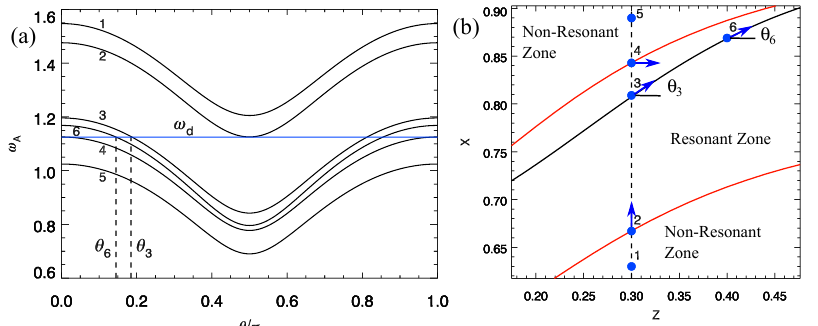
Figure 5. ( a ) The variation of natural Alfvén frequency, ω A , with polarisation angle, θ , for six different field lines, labelled 1–6. The horizontal blue line denotes the driving frequency, ω d . ( b ) The intersections of these field lines with the vertical ( x , z ) plane that runs the length of the arcade are shown as blue dots. The blue arrows indicate the polarisation required for the ω A to equal ω d , i.e., the resonance condition. The solid black line represents a permissible Resonant Path, and the red lines indicate the boundaries of the Resonant